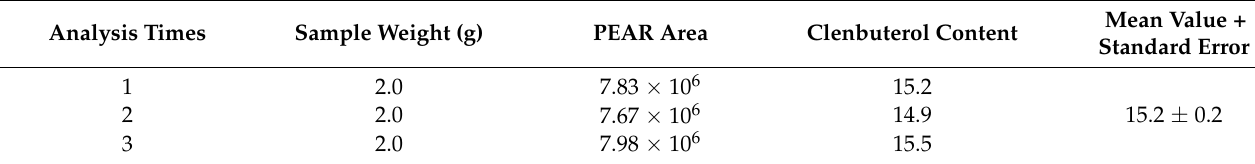
Table 5. Clenbuterol contents in the ham ( µ